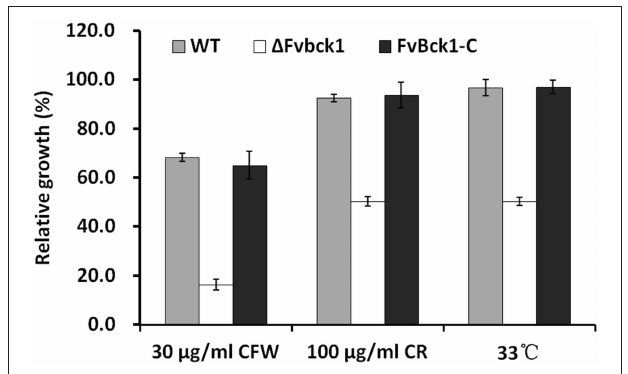
FIGURE 2 | The sensitivity of WT, 1 Fvbck1, and FvBck1-C strains to cell wall damaging agents and high temperature. The relative growth of each strain grown on CM plates with Calcofluor white (CFW) or Congo red (CR) at 26 ◦ C or without anything at 33 ◦ C for 4